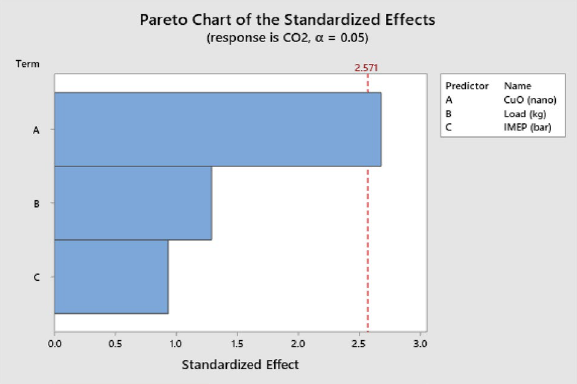
Fig. 16 Regression analysis: CO without nanoparticles